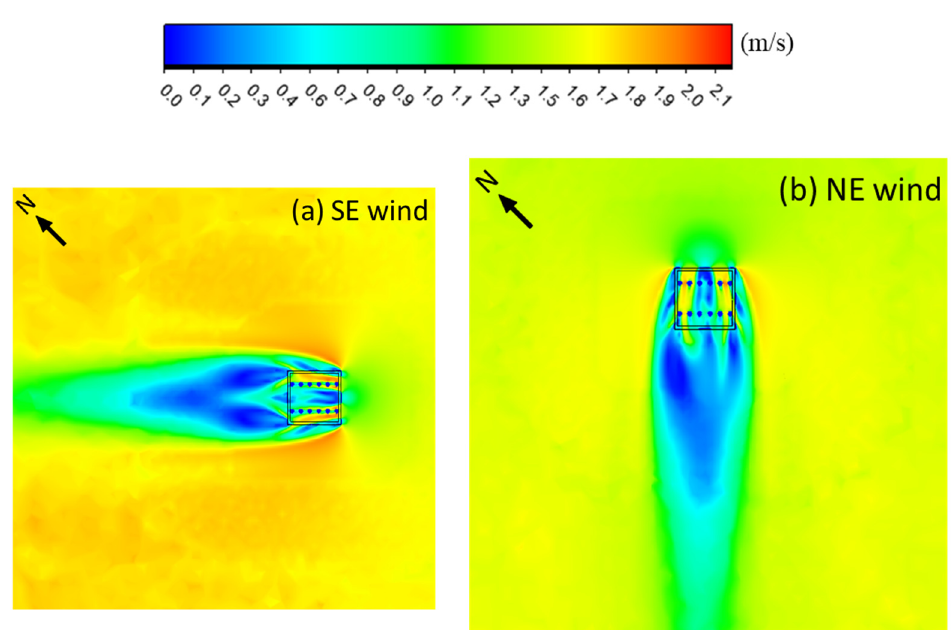
Figure A2. Velocity contours on the horizontal (x–y) plane: z = 1.1 m for ( a ) south-east wind, ( b ) north-east wind.